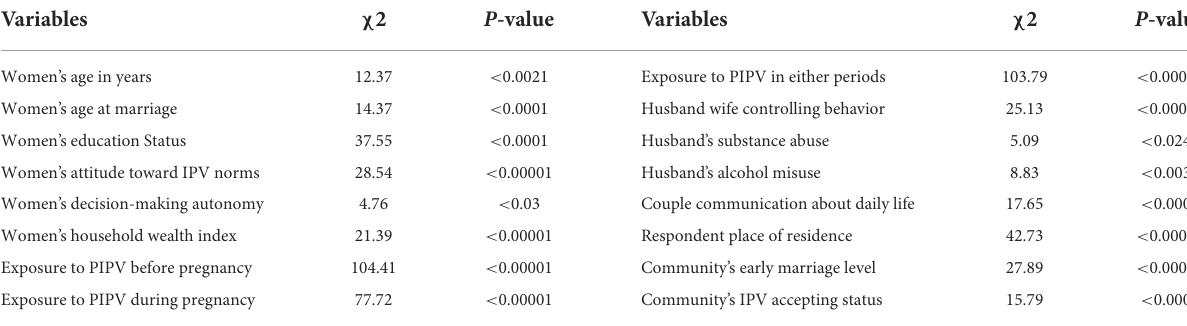
TABLE 3 Wilcoxon log-rank test for the length of time-to-postpartum contraception use among married women.